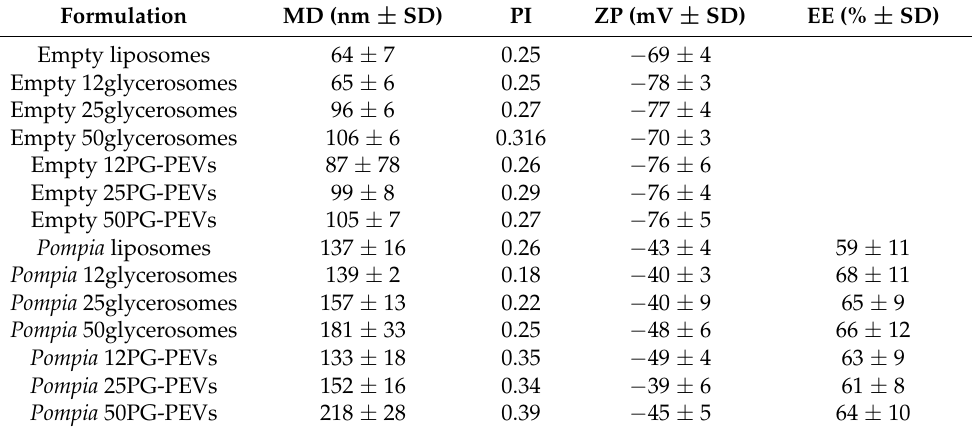
Table 3. Mean diameter (MD), polydispersity index (PI), zeta potential (ZP) and entrapment efficiency (EE) of empty and pompia extract loaded liposomes, glycerosomes and PG-PEVs. Mean values ± standard deviation (SD) were calculated from at least 3